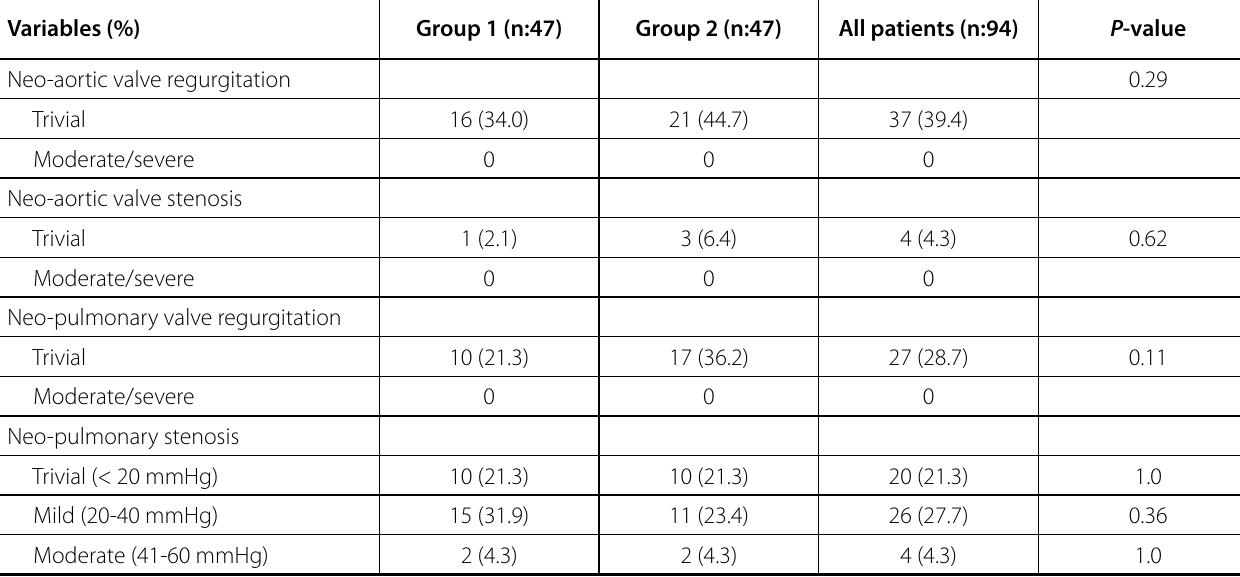
Table 4 . Postoperative echocardiographic data.